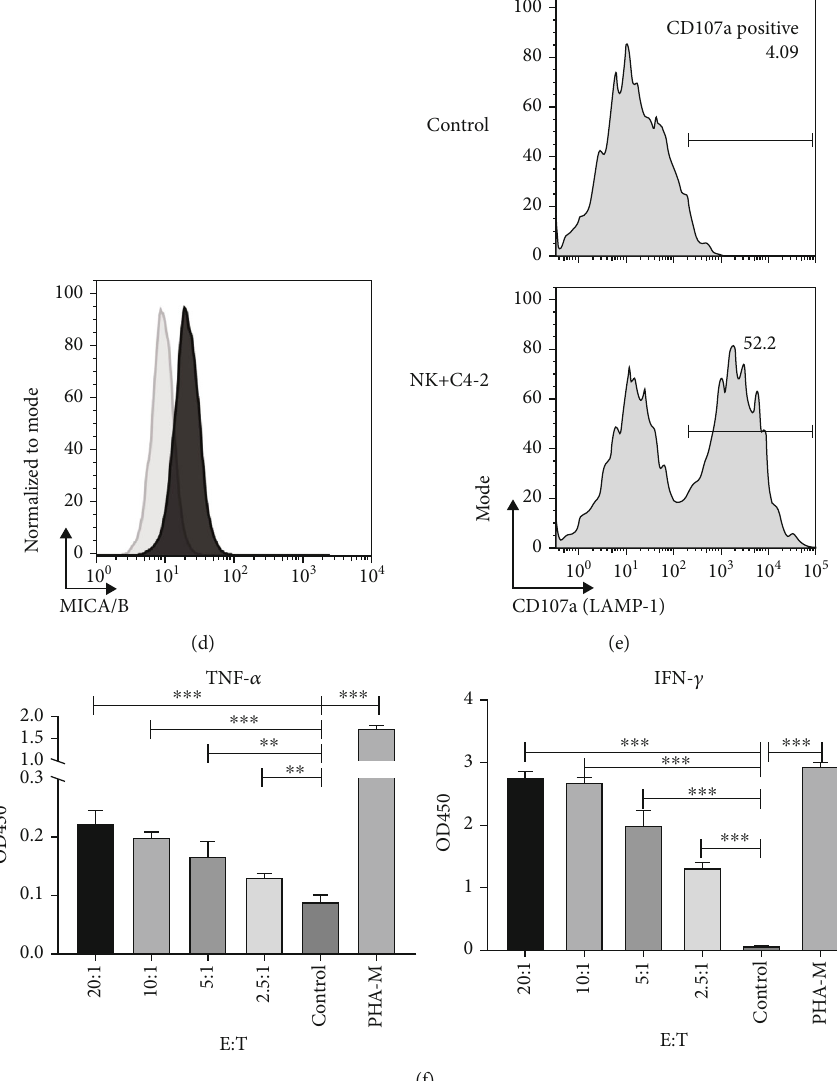
Figure 2: Cytotoxicity, degranulation activity, and cytokine secretion of the expanded NK cells. (a) Killing rates of the NK cells against multiple prostate cancer cell lines including C4-2, LNcap, PC-3, and DU-145 at di ff erent E/T ratios after 24h coculture. Data are shown as means ± SD ( n = 4 technical replicates). E / T : e ff ector-to-target ratio. (b) Comparison of killing rates against the C4-2 cell line between fresh NK cells and 1 month cryopreserved NK cells at di ff erent E / T ratios. Data are shown as means ± SD ( n = 4 technical replicates). ∗ p < 0 : 05 . E / T : e ff ector-to-target ratio. (c) Representative fl ow cytometry plots and data of NKG2D expression on CD3 − CD56 + NK cells. NKG2D: NK group 2 member D. (d) Representative fl ow cytometry plots and data of MICA/B expression on C4-2 cells. MICA/B: MHC class I chain-related protein A/B. (e) Representative fl ow cytometry plots and data of CD107a expression on the NK cells after being cocultured with C4-2 cells and NK cell alone. (f) IFN- γ and TNF levels of the supernatant after the NK cells were cocultured with C4-2 cells at E / T ratios of 2.5:1, 5:1, 10:1, and 20 :1 or stimulated with PHA-M for 12 hours. Values are expressed as the means ± SD , ∗∗ p < 0 : 01 ; ∗∗∗ p < 0 : 001 . OD: optical density; E / T : e ff ector-to-target ratio; PHA-M: